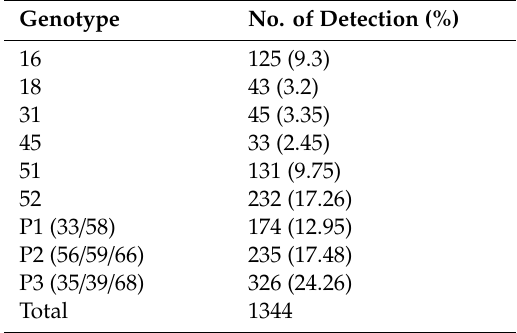
Table 5. HPV genotype prevalence in the BD Onclarity ™ HPV assay group.